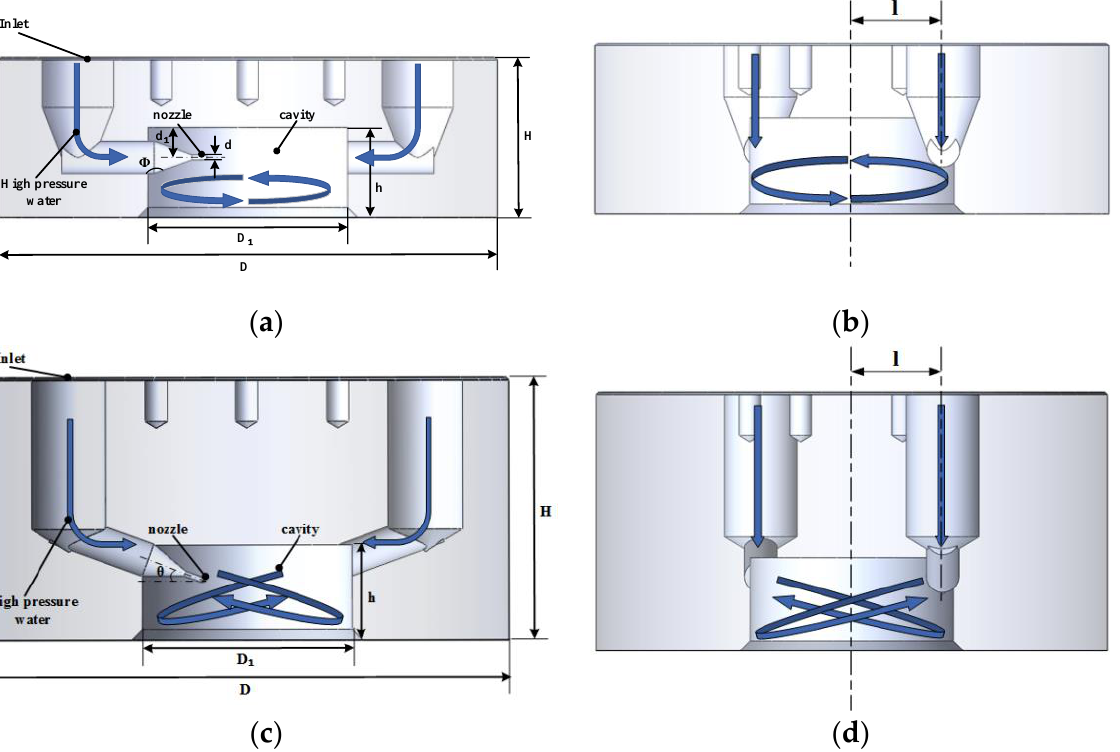
Figure 1. Figures of the vortex suction cup (including the sketch of the streamline): ( a ) front view of schematic structure of the original suction cup; ( b ) left view of schematic structure of the original suction cup; ( c ) front view of schematic structure of the optimized suction cup; ( d ) left view of schematic structure of the optimized suction